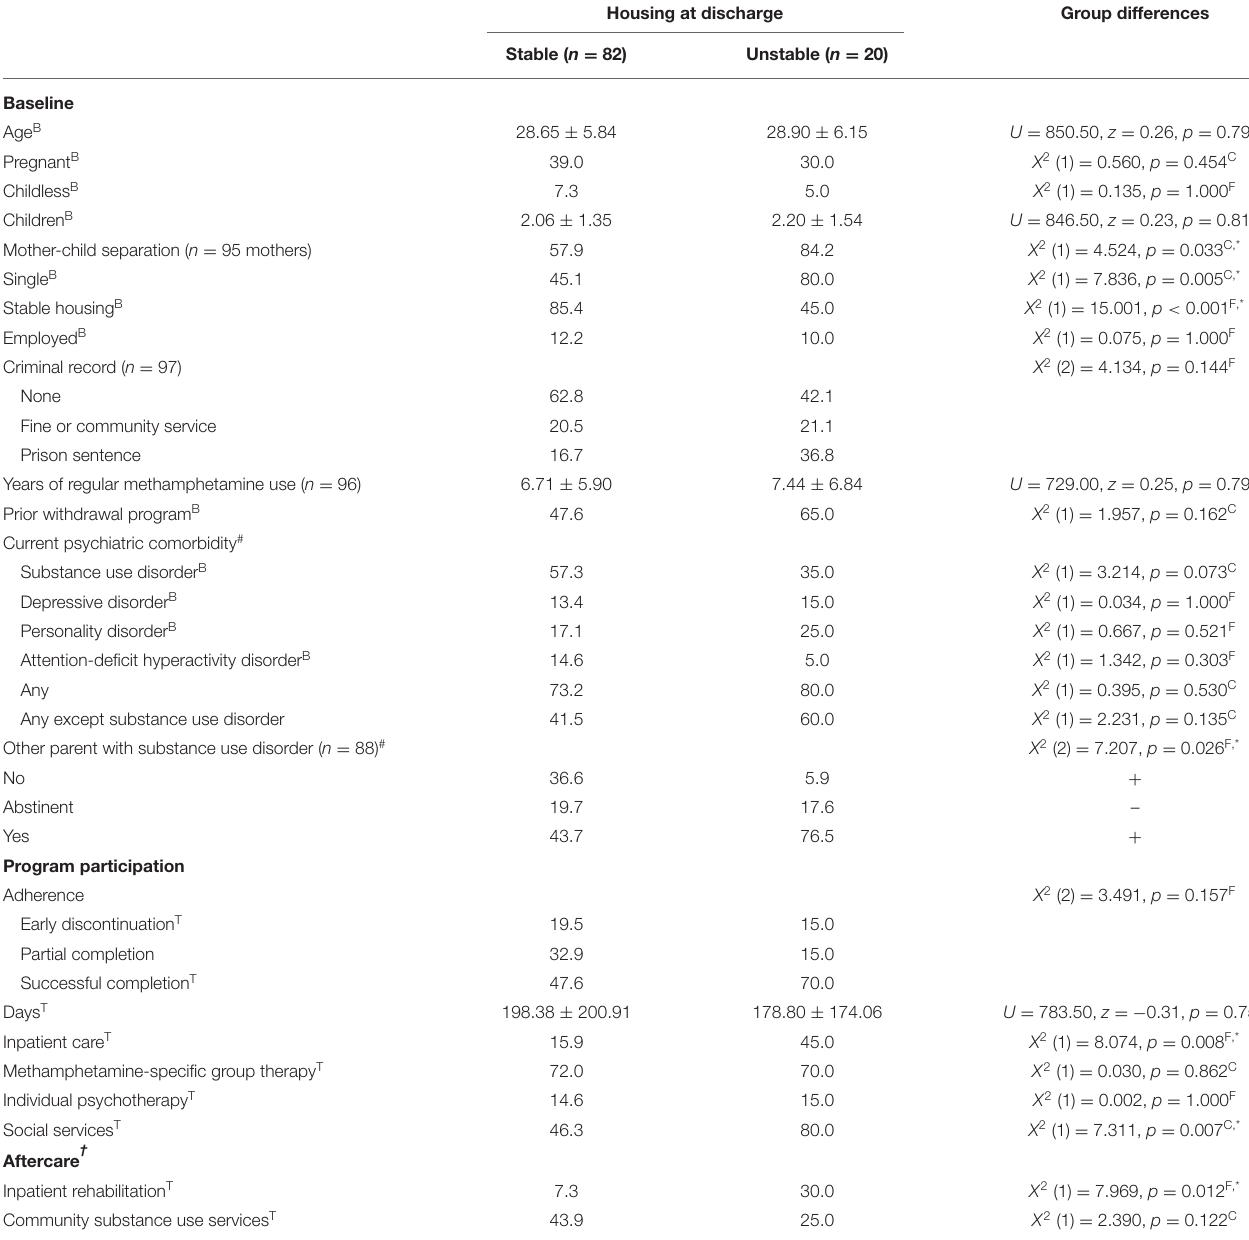
TABLE 2 | Patient characteristics by housing at